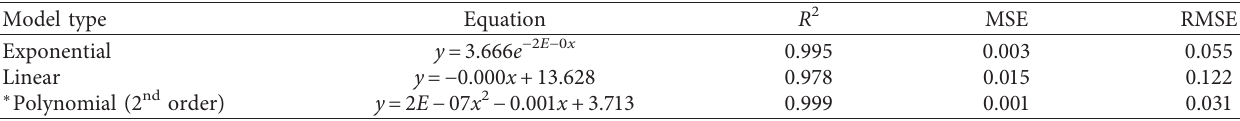
Table 5: Summary of regression models for total cholesterol (TC) in serum.